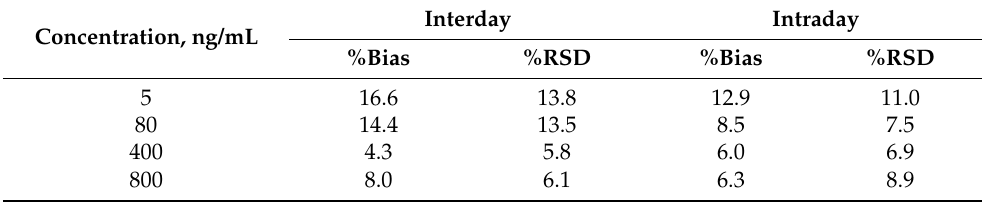
Table 1. Intraday and interday accuracy and precision.